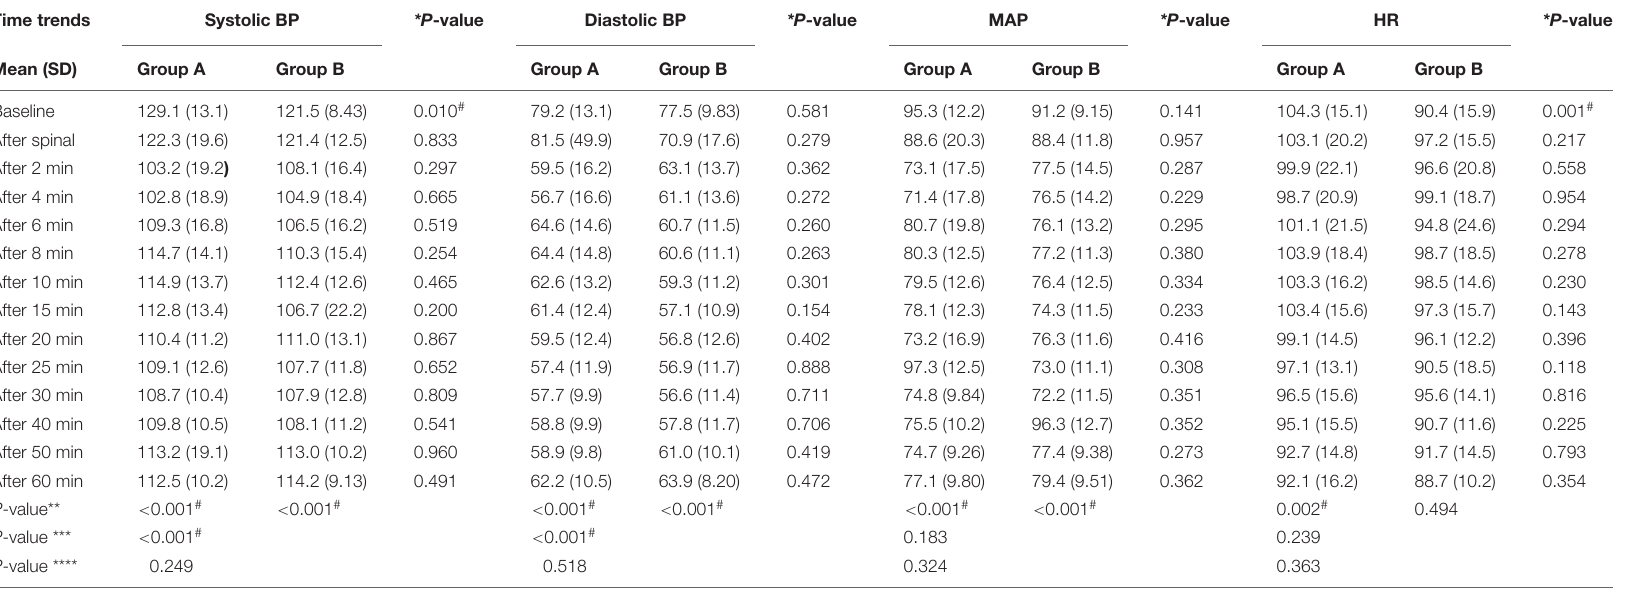
TABLE 4 | Comparison of hemodynamic parameters in the intervention and control groups according to time